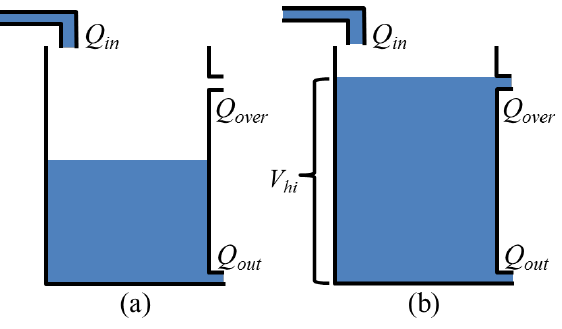
Figure 4. A schematic showing how the dynamic equations representing a simple tank change when the tank overflows. ( a ) is with no overflow; and ( b ) is when there is